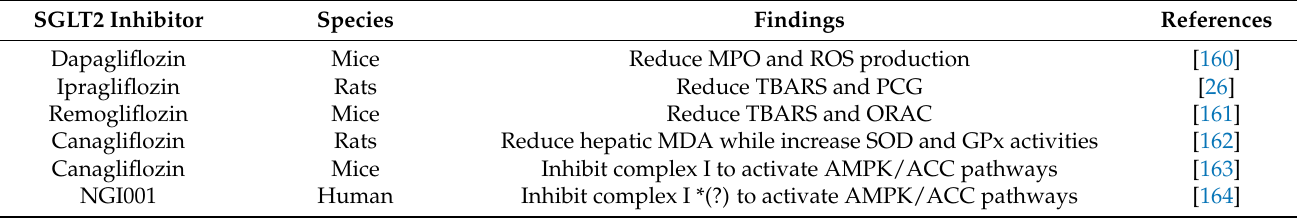
Table 2. Preclinical studies demonstrating SGLT2 inhibitors as antioxidants in nonalcoholic fatty liver disease (NAFLD). SGLT2 Inhibitor Species